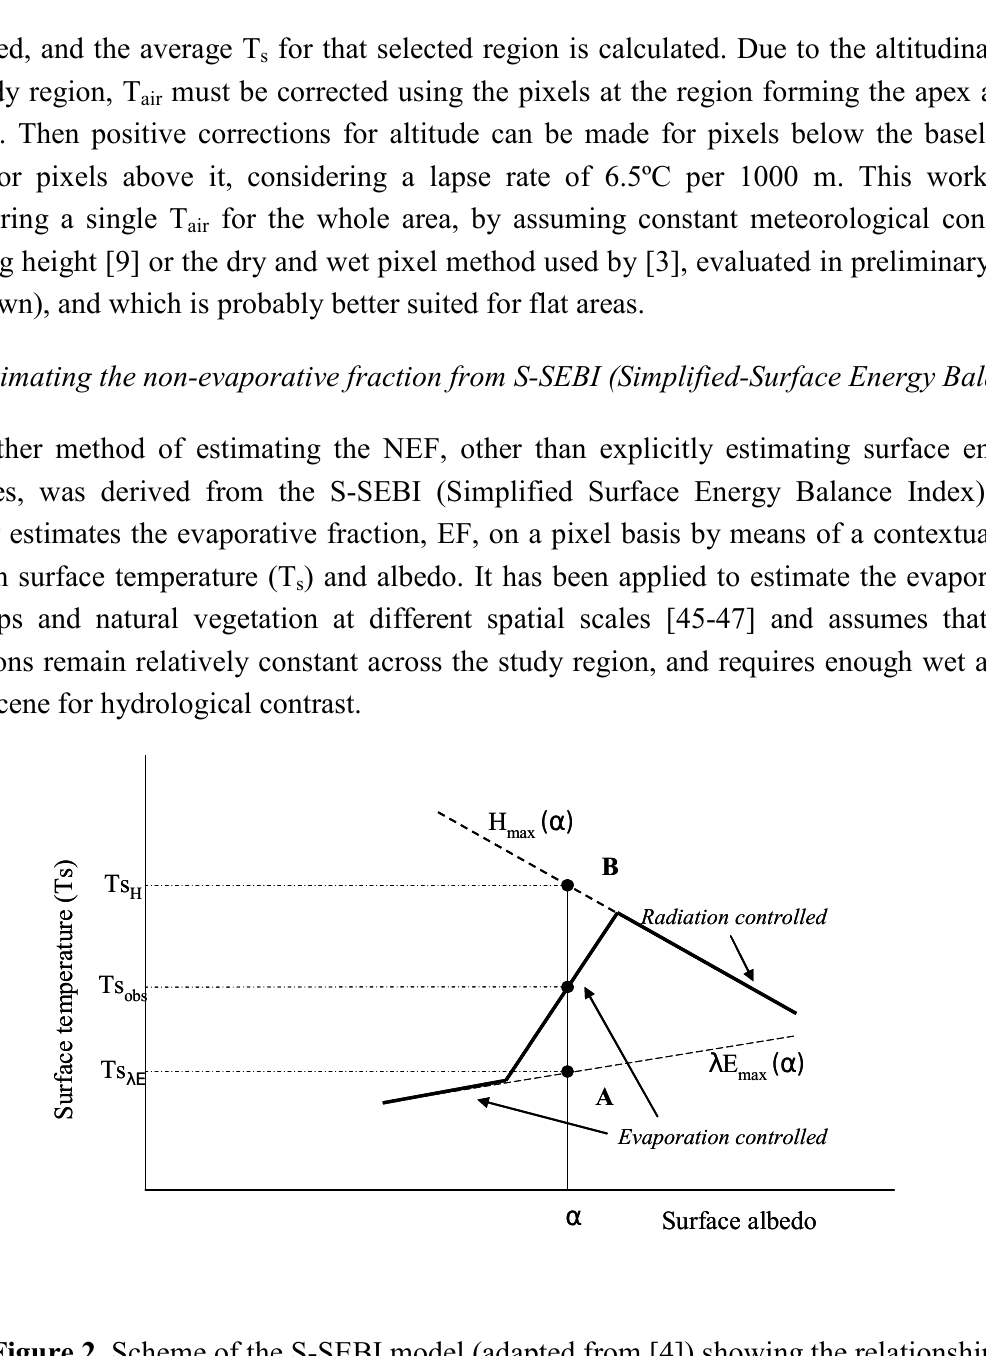
Figure 2. Scheme of the S-SEBI model (adapted from [4]) showing the relationship between surface albedo (α) and surface temperature (Ts). “A” and B” correspond to the evaporation-controlled and radiation-controlled domains, respectively. Ts is the observed temperature, Ts l is the obs E temperature in the evaporation-controlled domain and Ts is the temperature in the radiation- H controlled